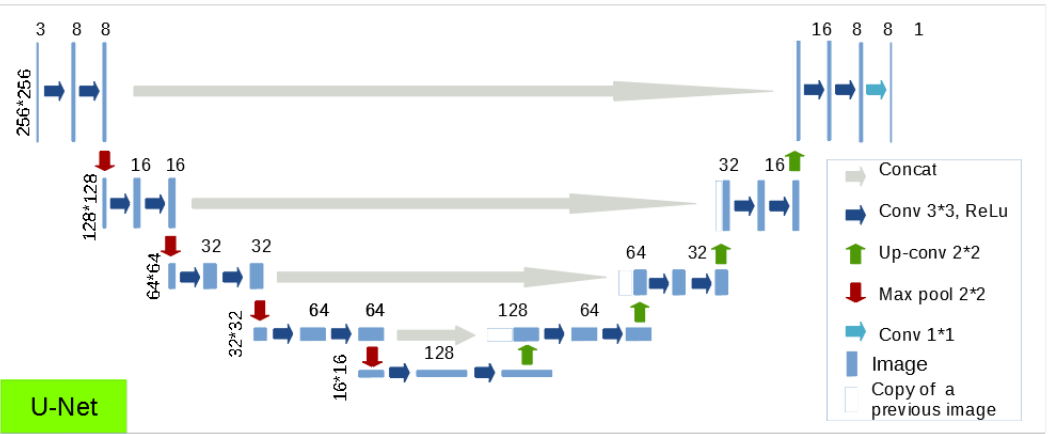
Figure 6. Model architecture for mountain roads